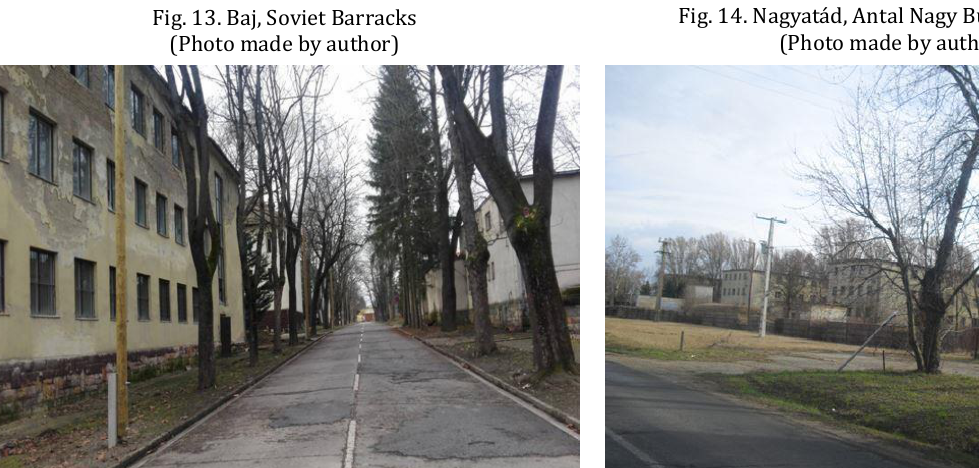
Fig. 13. Baj, Soviet Barracks Fig. 14. Nagyatád, Antal Nagy Budai Barracks